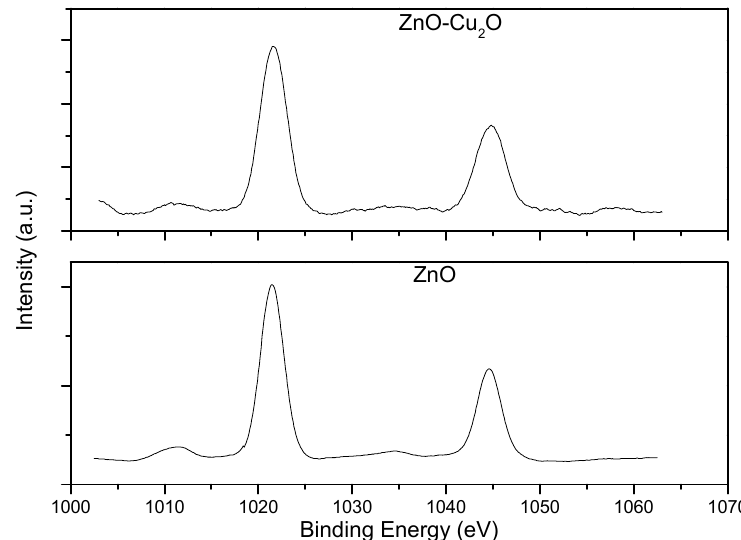
Figure 3. The Zn 2p X-ray photoelectron spectroscopy (XPS) of ZnO and ZnO-Cu 2 O.